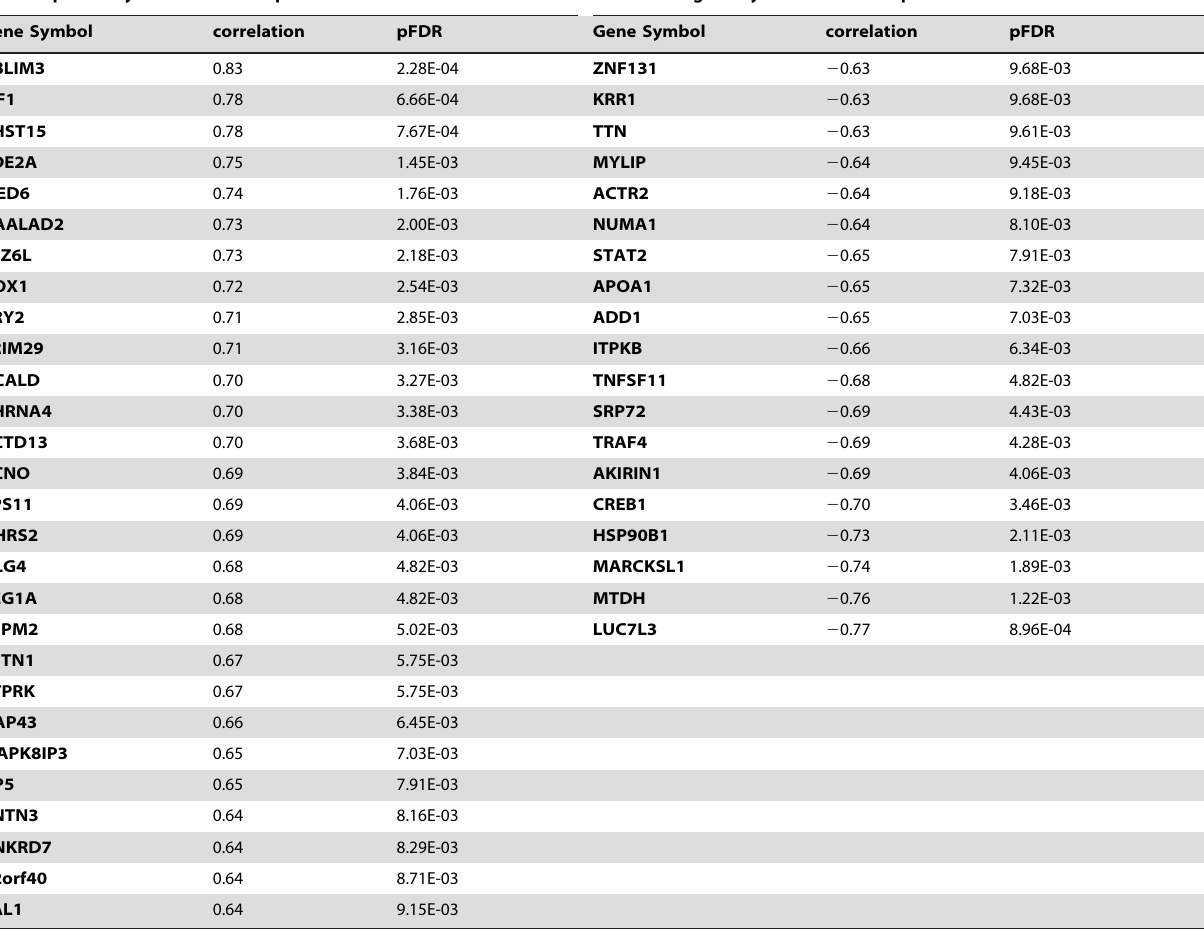
Table 2. Forty-seven genes showed expression changes that were significantly correlated with the